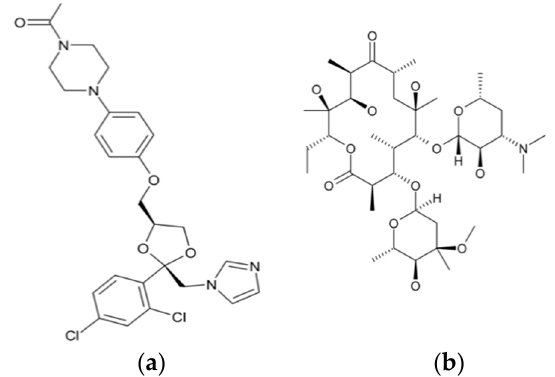
Figure 2. Chemical structures of ketoconazole ( a ) and erythromycin ( b ).